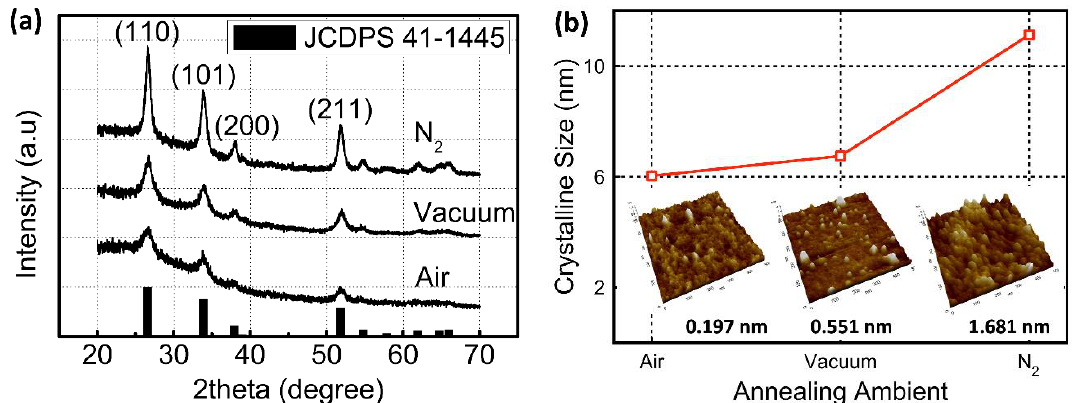
Figure 1. ( a ) GIXRD patterns and ( b ) calculated crystalline sizes of the SnO 2 films annealed in air, vacuum, and N 2 . The inset shows the SPM